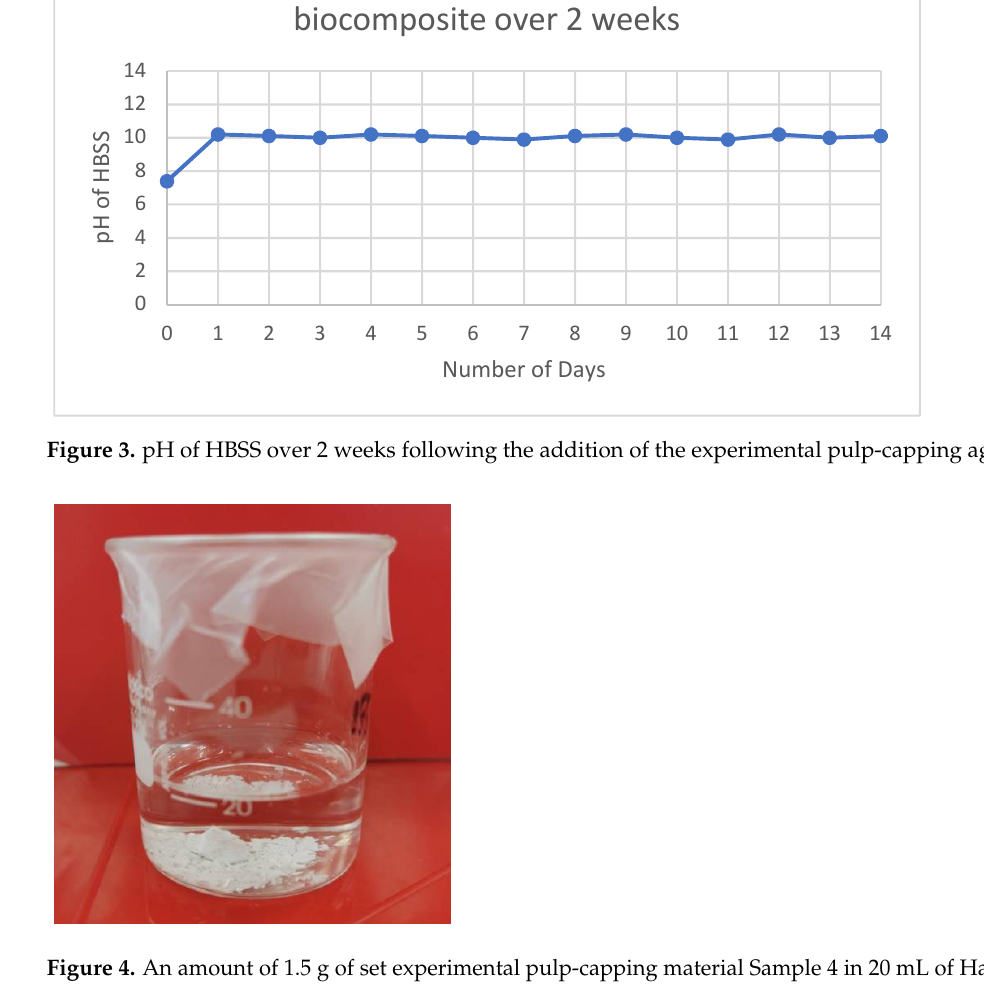
Figure 4. An amount of 1.5 g of set experimental pulp-capping material Sample 4 in 20 mL of Hank’s Balanced salt solution.